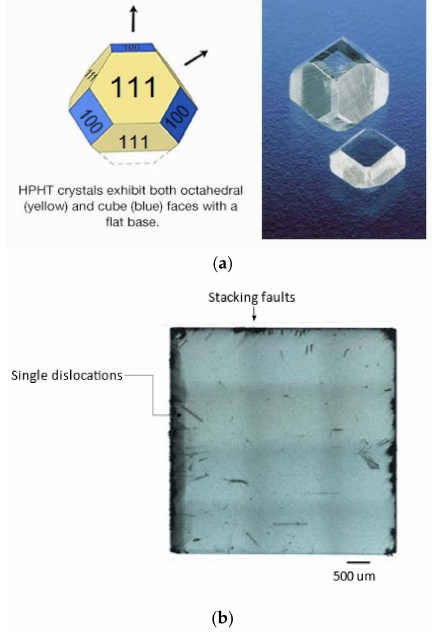
Figure 6. The type IIa single crystal diamond produced by HPHT; the crystal is in cuboctahedral form and different crystal planes such as (100) and (111) are visible in ( a ). An X-ray topography image of a type IIa plate. Few line dislocations and stacking faults at the edge of the plate are seen ( b ). The size of the plate in ( b ) is about 3.5 mm × 3.5 mm. Image is taken from ref. [42]: Shikata, S. Diamond dislocations analysis by X-ray topography Funct. Diam. 2022 , 2 , 174. Reprinted by permission of Taylor & Francis Ltd, http://www.tandfonline.com (accessed on 1 February 2023) on behalf of Zhengzhou Research Institute for Abrasives & Grinding Co., Ltd.